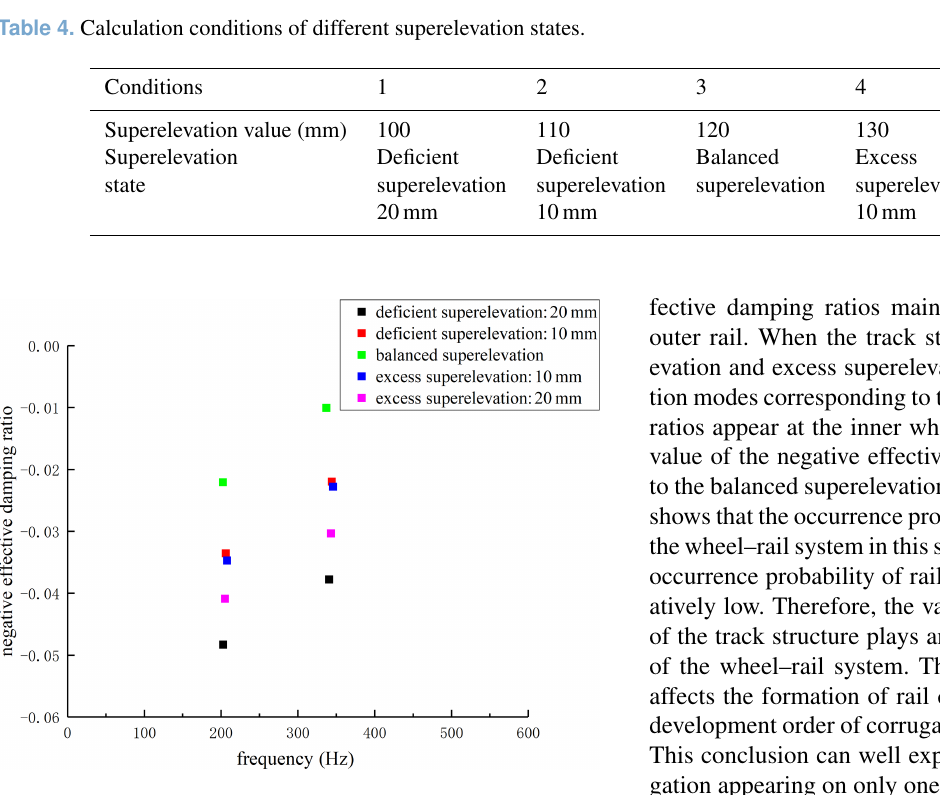
Figure 8. Distribution diagram of negative effective damping ra-